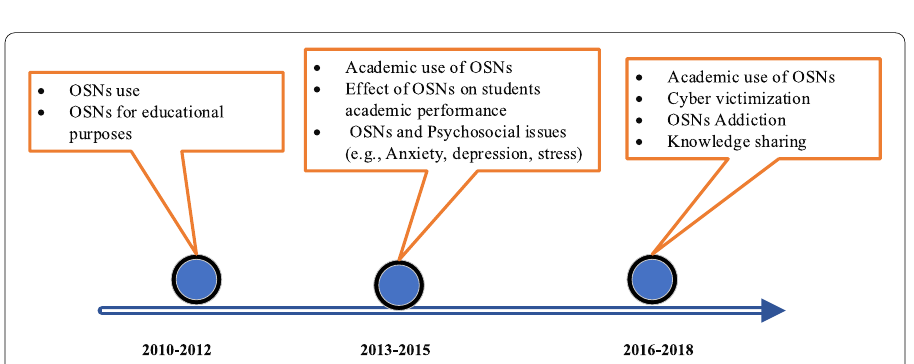
Fig. 3 Evolution of OSNs studies over the